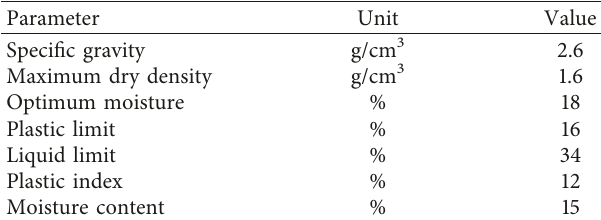
Figure 6: Arrangement and number of displacement sensor. Table 2: Basic physical properties of test soil.